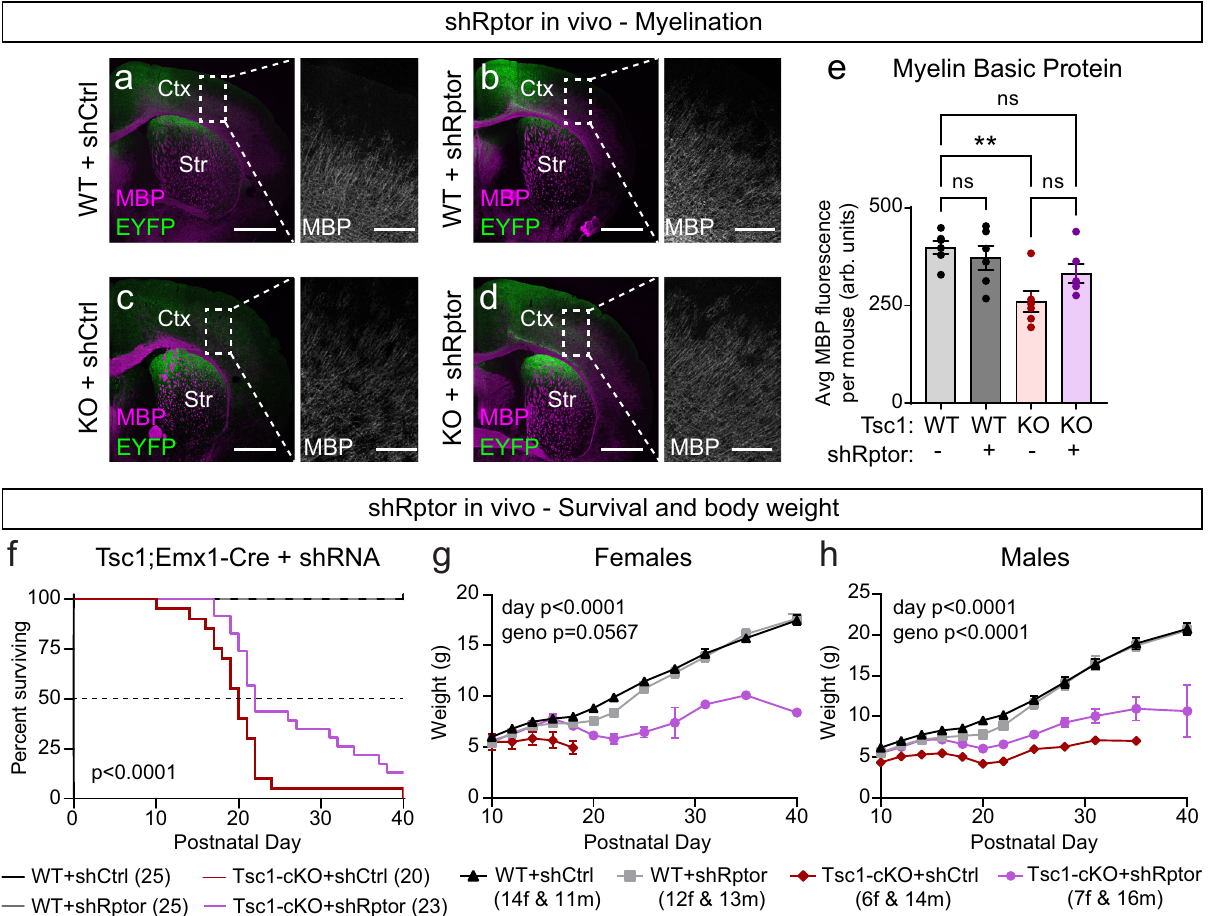
Fig.9|PostnatalRaptorreductionimprovesmyelinationandextendssurvival of Tsc1-cKO mice. a – d Representative images of somatosensory cortex from mice of the indicated genotypes and treatments, showing EYFP (green) and myelin basic protein (MBP, magenta) immunostaining. Scale bars = 1 mm. Ctx = cortex, Str = striatum. Right panels show zoomed-in images of MBP immu- nostaining within the boxed cortical regions;scale bars = 250 μ m. e Mean ± SEM bulk MBP fl uorescence intensity in the boxed cortical regions shown in panels ( a – d ) for the indicated genotypes. Dots represent individualmice. n = 6 animals per condition. Kruskal – Wallis, p = 0.0114; WT+shCtrl vs WT+shRptor, p > 0.9999; WT+shCtrl vs Tsc1-KO+shCtrl, ** p = 0.0077; WT+shCtrl vs Tsc1-KO +shRptor, p = 0.4833; Tsc1-KO+shCtrl vs Tsc1-KO+shRptor, p = 0.4833; Dunn ’ s multiple comparison tests. Tests were two-sided and P values were adjusted for